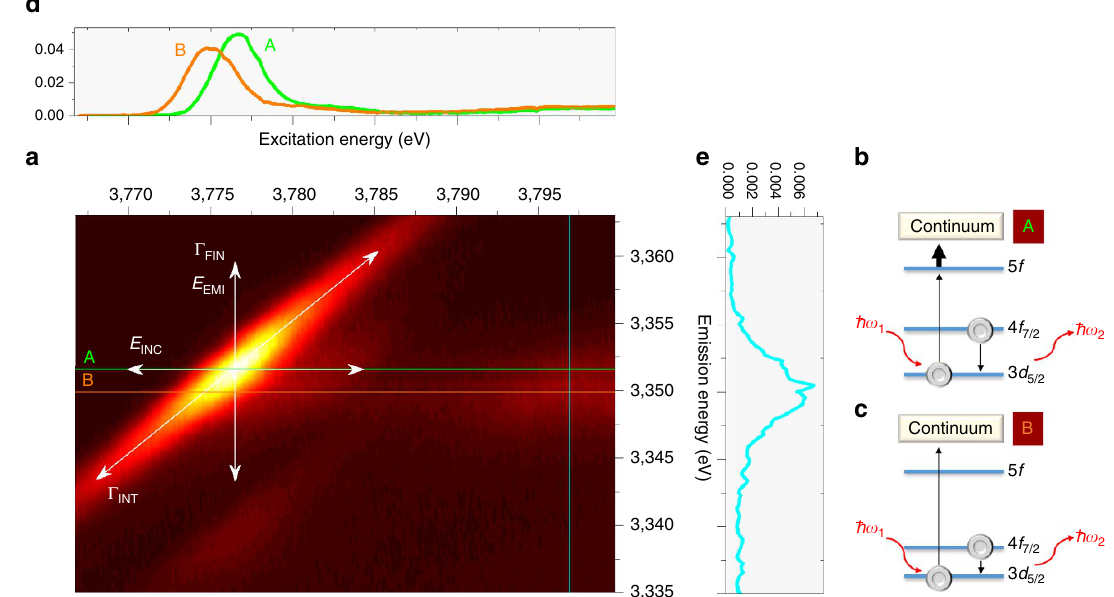
Figure 2 | RIXS map of PuO 2 and schematics of the emission process. ( a ) 3 d 4 f RIXS map of PuO 2 . ( b ) One-electron scheme of the emission process for excitation energies of about 3,776.5eVand ( c ) above 3,785eV. The intense resonant structures at about 3,351.6eV emission energy in the 3 d 4 f RIXS map correspond to 4 f 7/2 - 3 d 5/2 Pu M a emission, whereas the peaks with weaker intensity at about 3,340eV emission energy describe 4 f 5/2 - 3 d 5/2 Pu M a emission. The energy positions of the most intense resonance (3,351.6eV) and the normal emission line (3,350eV) for the 3 d 5/2 - 5 f Pu M 5 absorption edge and 4 f 7/2 - 3 d 5/2 Pu M a emission, are marked with lines A and B, respectively; ( d ) the HR-XANES extracted for lines A and B; ( e ) the emission line measured at 3,797eVexcitation energy. The experimental broadening depending on the specifications of the beamline ( E INC ), and the spectrometer ( E EMI ), as well as the core-hole lifetime broadening effects in the intermediate ( G EMI ) 3 d 9 5 f N þ 1 ( N ¼ number of electrons in the An 3 d 10 5 f N ground state) and final ( G FIN ) 4 f 13 5 f N þ 1 states, are